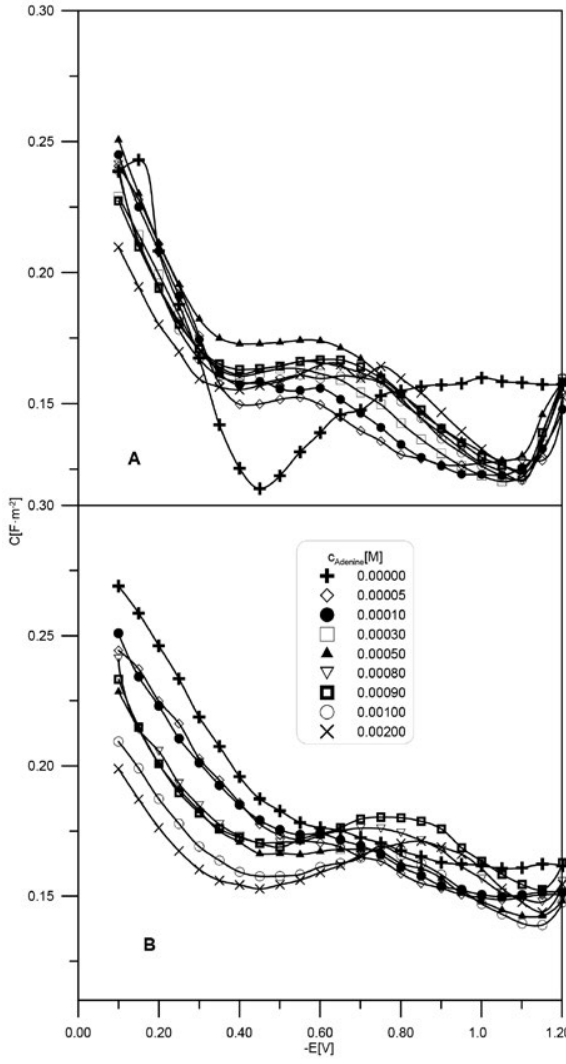
Figure 3. The differential capacity-potential curves at Hg/acetic buffer pH 3 (A) pH 4 (B) for various adenine concentrations as in figure